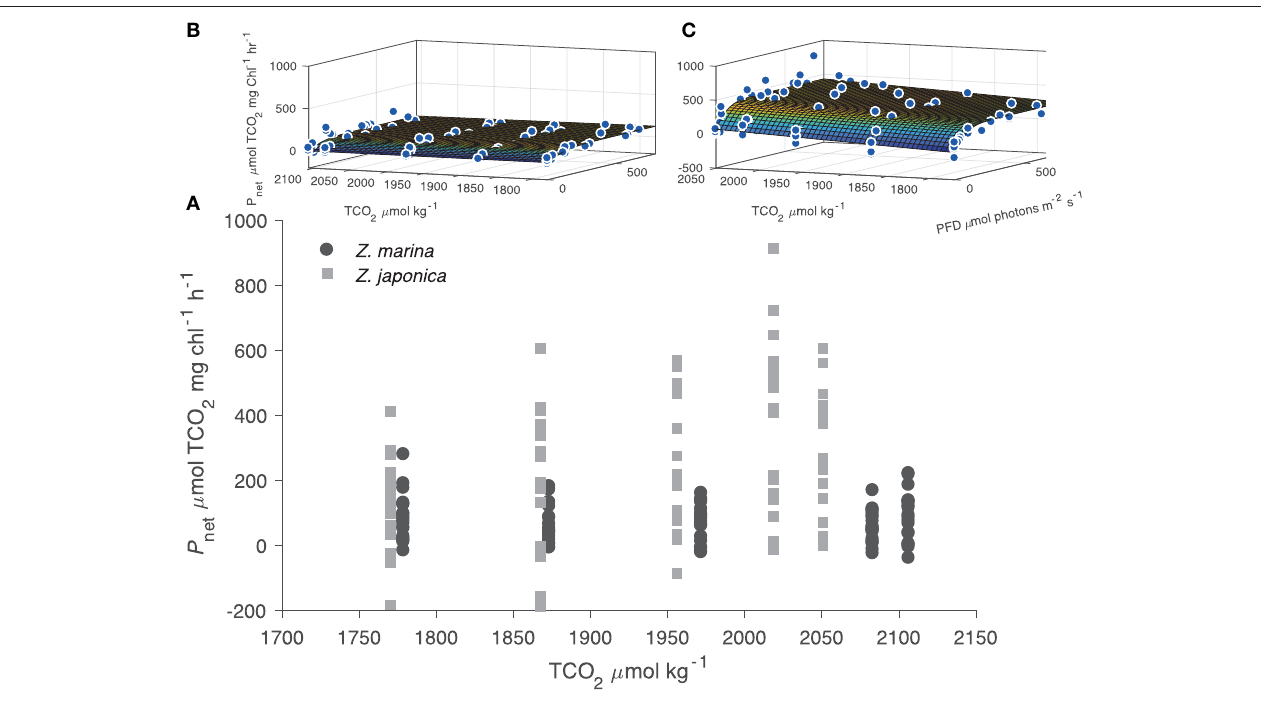
FIGURE 2 | (A) Experimental results of net photosynthetic rates ( P net µ mol TCO 2 mg chl − 1 h − 1 ) for Z. marina (closed circles) and Z. japonica (closed squares) plotted against initial TCO